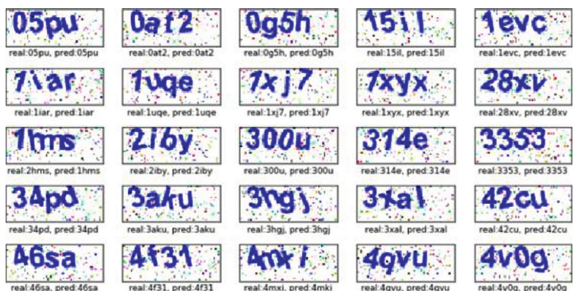
Figure 11: Recognition results on